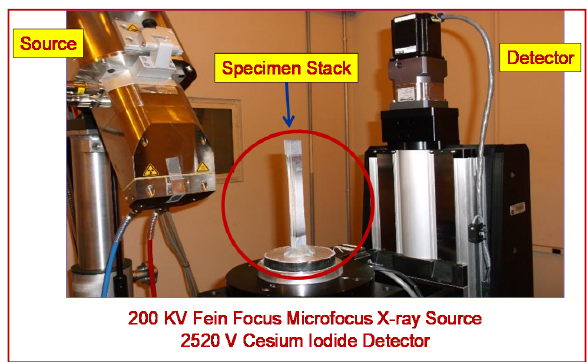
Figure 3. Photograph of the computed tomography facility at NASA Glenn.